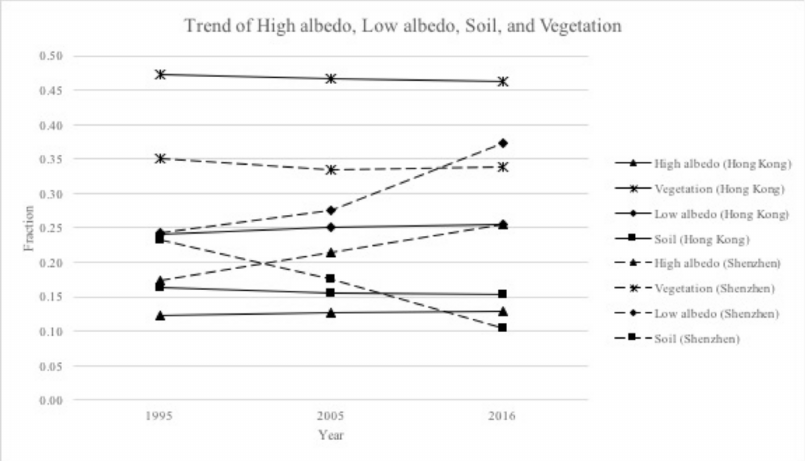
Figure 13. Trend of high-albedo, low-albedo, soil, and vegetation for Hong Kong and Shenzhen.